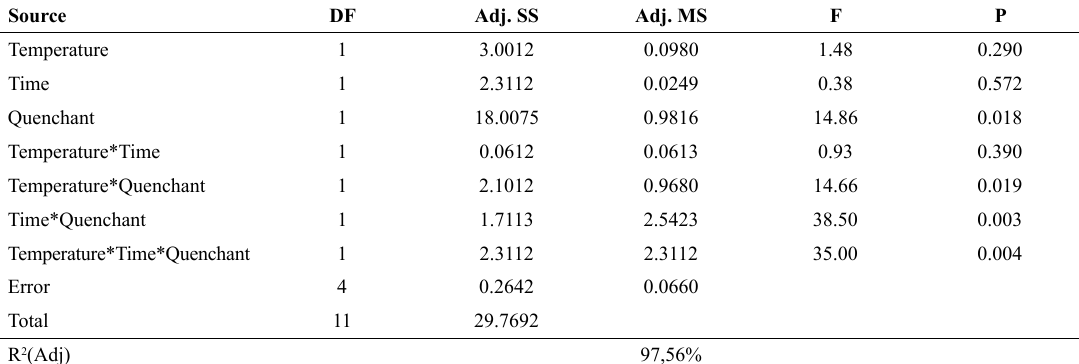
Table 5. Analysis of variance (ANOVA): Hardness.